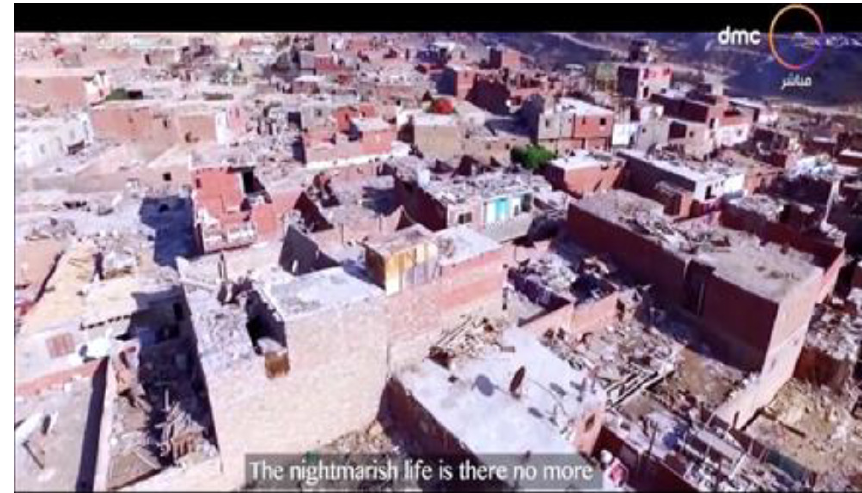
Figure 2. Still image from Man Ahyaha